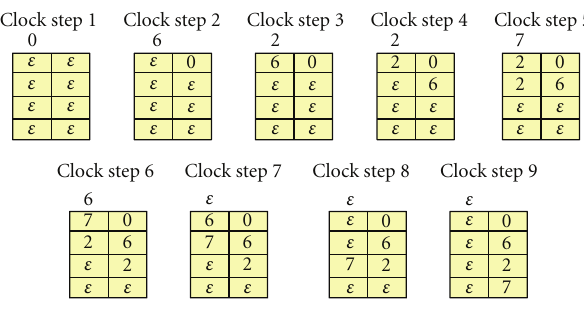
Figure 3: Systolic array implementing the distinctness operation for X = 0,6,2,2,7,6. Each row represents a cell. Within each cell, the left and right columns represent the S and M registers, respectively. Elements are input to the top row and flow downwards.